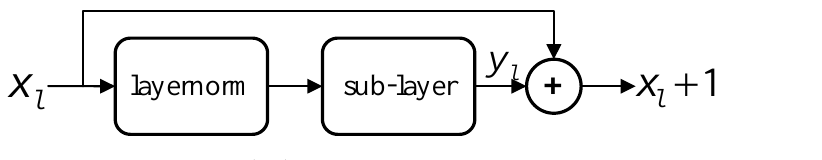
Figure 10. Pre-norm residual unit.